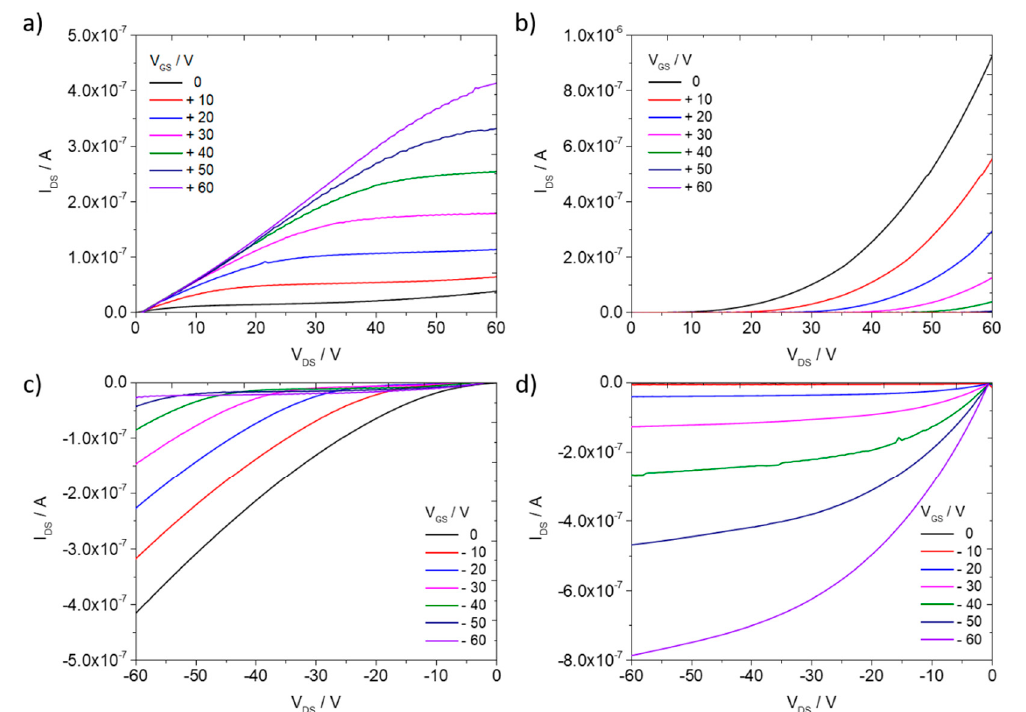
Figure 7. Output characteristics of OFETs based on PBTTT-C 14 :PDI8-CN 2 BHJ films spin-coated at 4000 rpm and a solution temperature of 100 °C for ( a , b ) n- and ( c , d ) p-type regimes; ( a , c ) before and ( b , d ) after thermal annealing at 200 °C.